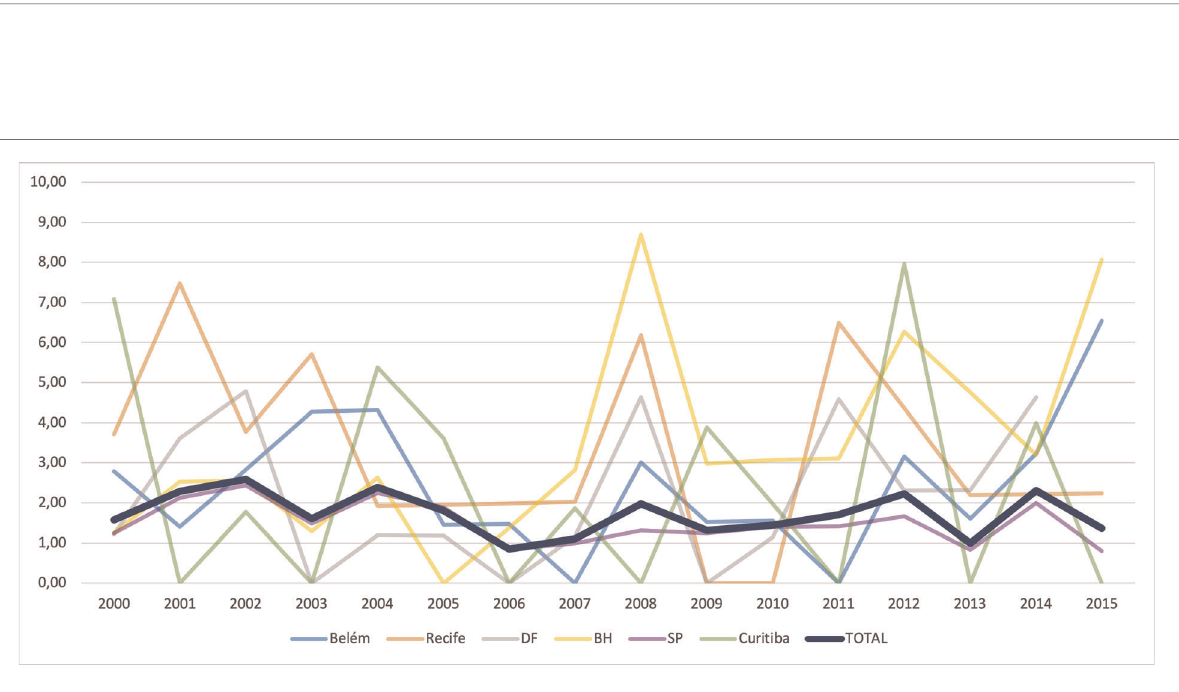
FIGURE 4 Time evolution of retinoblastoma incidences in six municipalities in the fi ve Brazilian regions and the total combined incidence, from 2000 to 2015.